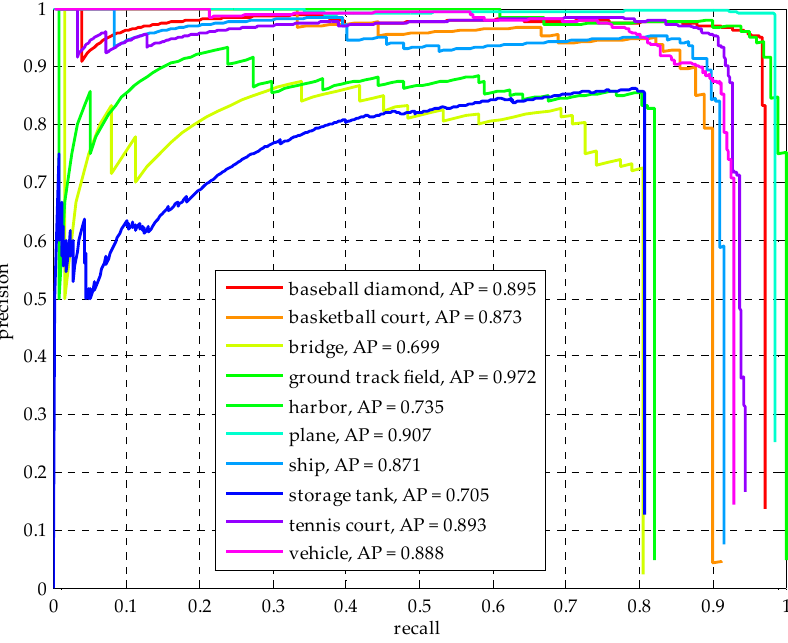
Figure 5. Precision versus recall curve for the proposed method over the NWPU VHR-10 dataset.